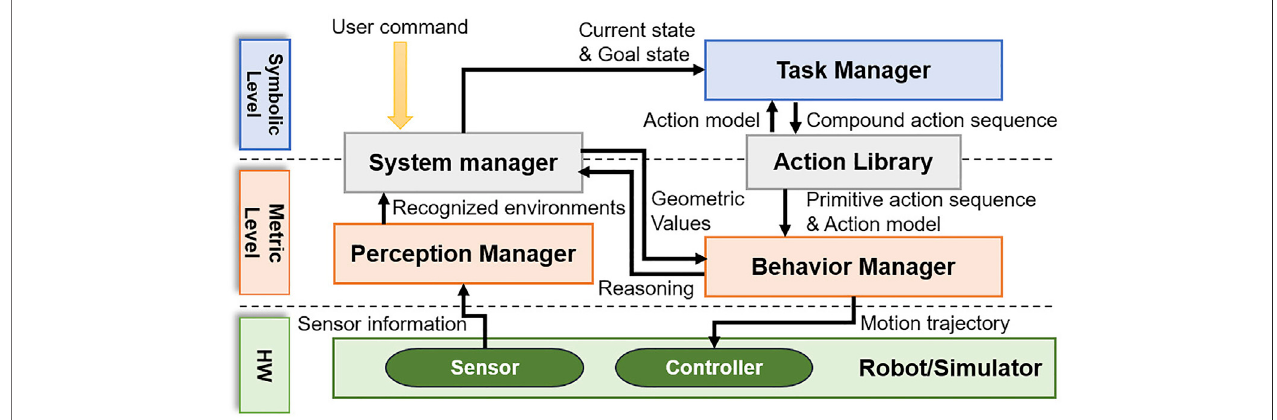
FIGURE 1 | Overview of the proposed task and motion planning